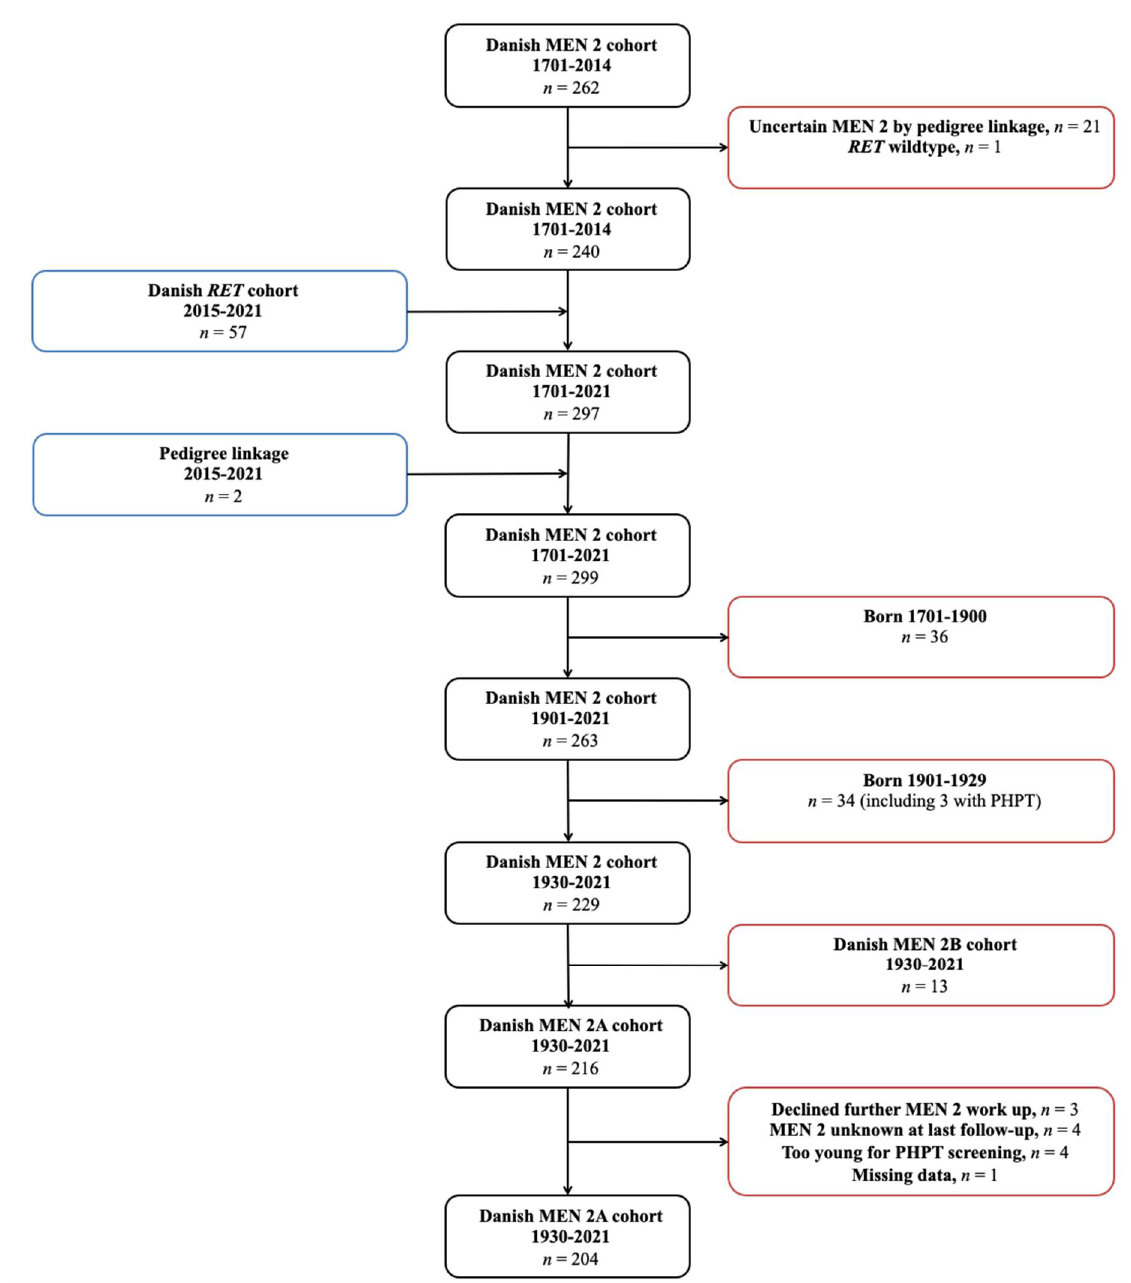
Figure 1. Flowchart showing identification of the Danish MEN 2A cohort 1930–2021. Abbreviations: MEN 2, multiple endocrine neoplasia type 2; RET , RE arranged during T ransfection; PHPT, primary hyperparathyroidism.